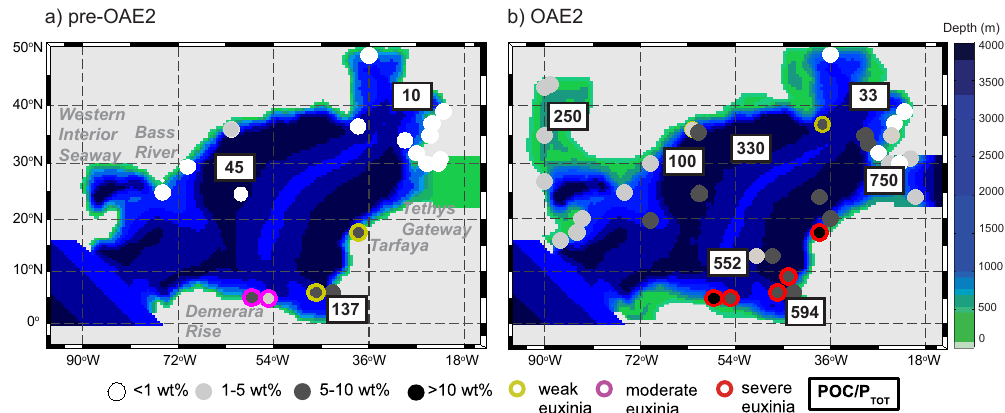
Fig. 1. Bathymetry of the proto-North Atlantic (a) prior to OAE2 and (b) during OAE2 as reconstructed by Topper et al. (2011). Dots indicate locations for which the sediment organic carbon contents are known, with the extent of grey to black shading of the dots being indicative of the average organic carbon content. Circles around the dots indicate where bottom waters were euxinic, with the colour scale from yellow to red being indicative of the severity and/or duration of euxinia. Average ratios of particulate organic carbon to total phosphorus (POC/P TOT ) are indicated as numbers. The corresponding data and references are provided in Table S1 (Supplement). For (a) , we consider the 200kyr prior to